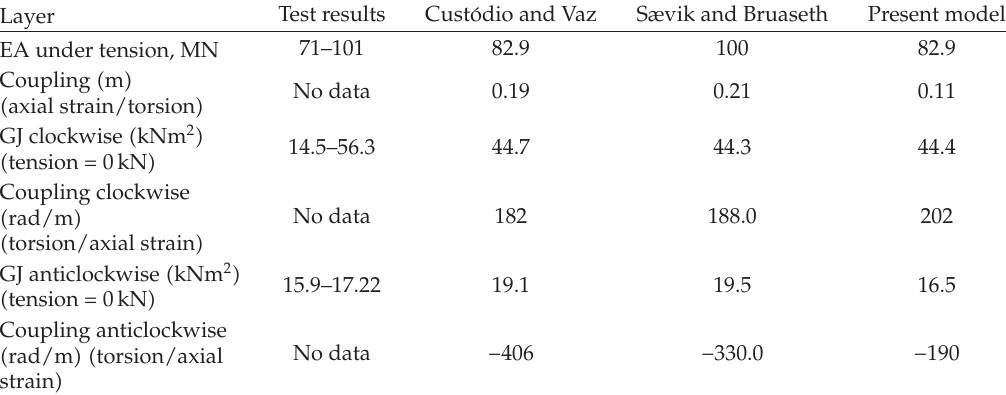
Table 2: Comparison with Cust´odio and Vaz test data, simulation data from Custido and Vaz, and simulated results from Sævik and Bruaseth.